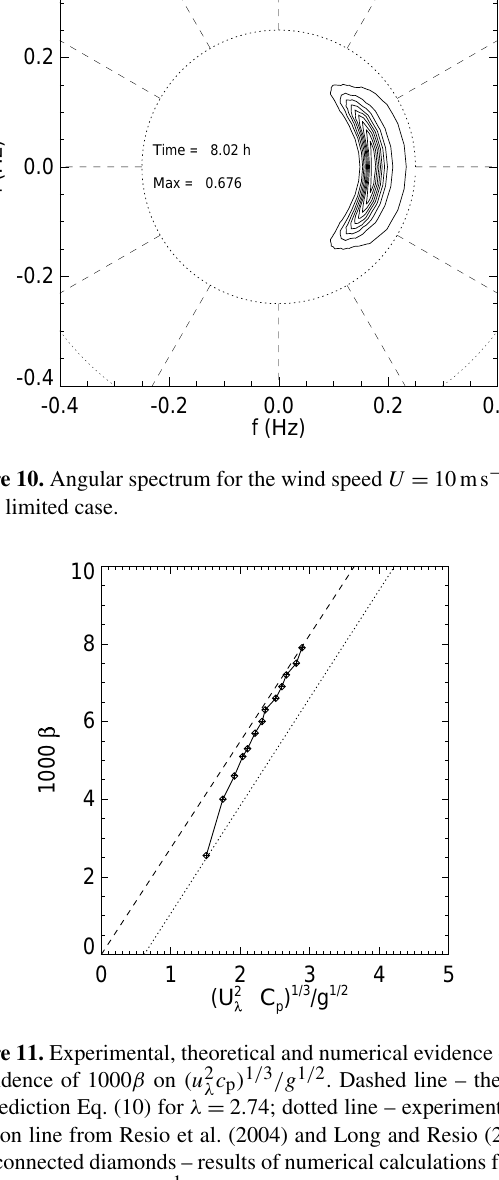
The compensated spectrum F(k) · k 5 / 2 is presented in Fig.